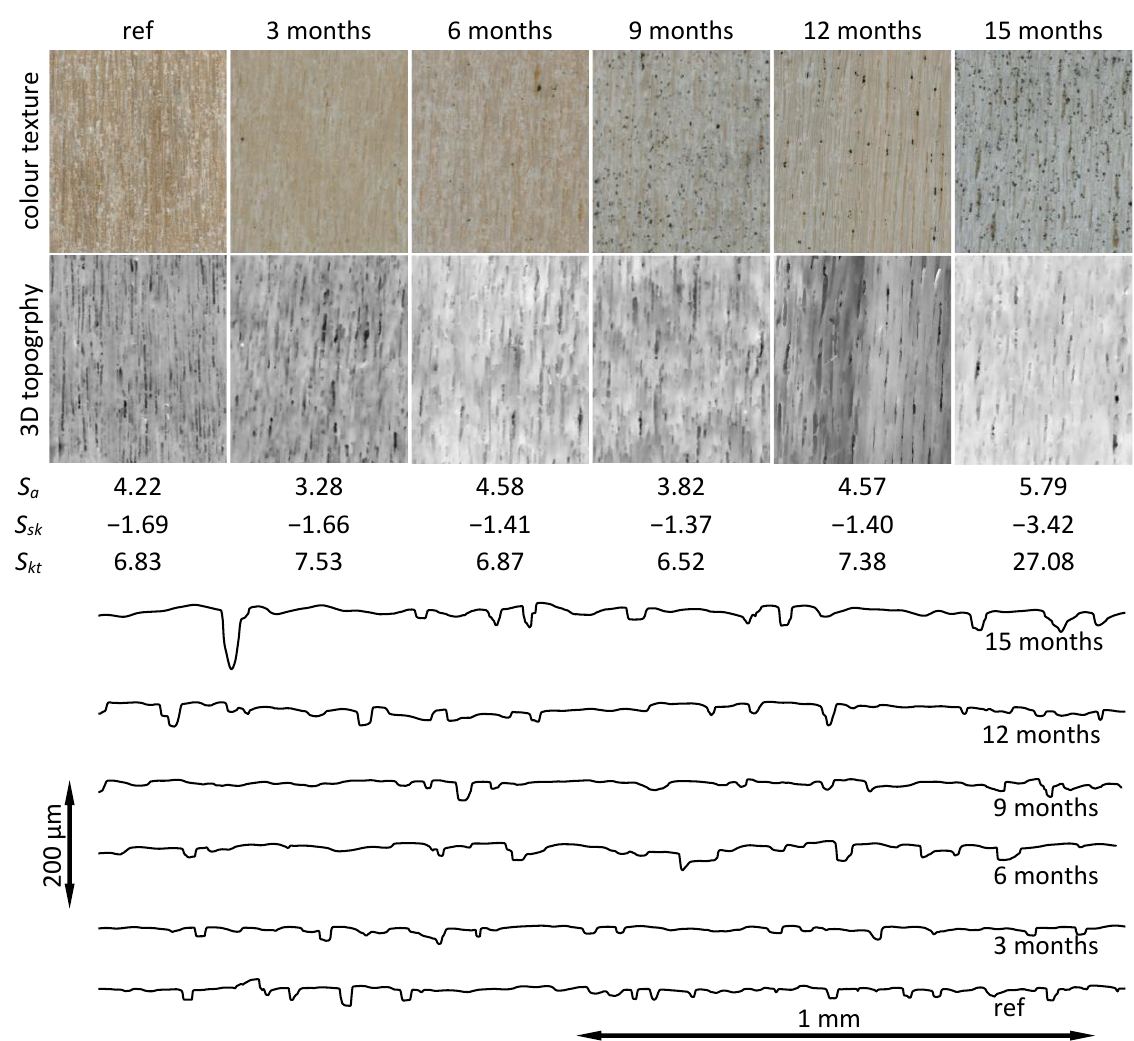
Figure 4. 3D surface topography map, typical surface profiles and high magnification images of the acetylated radiata pine wood (sample #4) exposed to natural weathering for a period of 15 months.